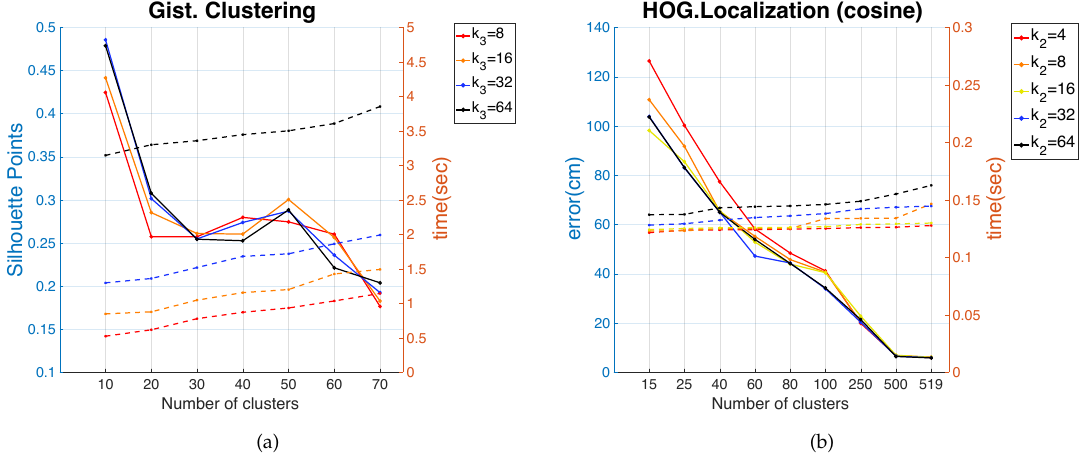
Figure 21. Best results of the clustering and localization processes. ( a ) Clustering with gist and spectral clustering: silhouette of points (left axis, solid lines) and computing time (right axis, dashed lines) vs. number of clusters. ( b ) Localization with HOG and cosine distance: average localization error (cm) (left axis, solid lines) and computing time (right axis, dashed lines) vs. the number of clusters. Freiburg